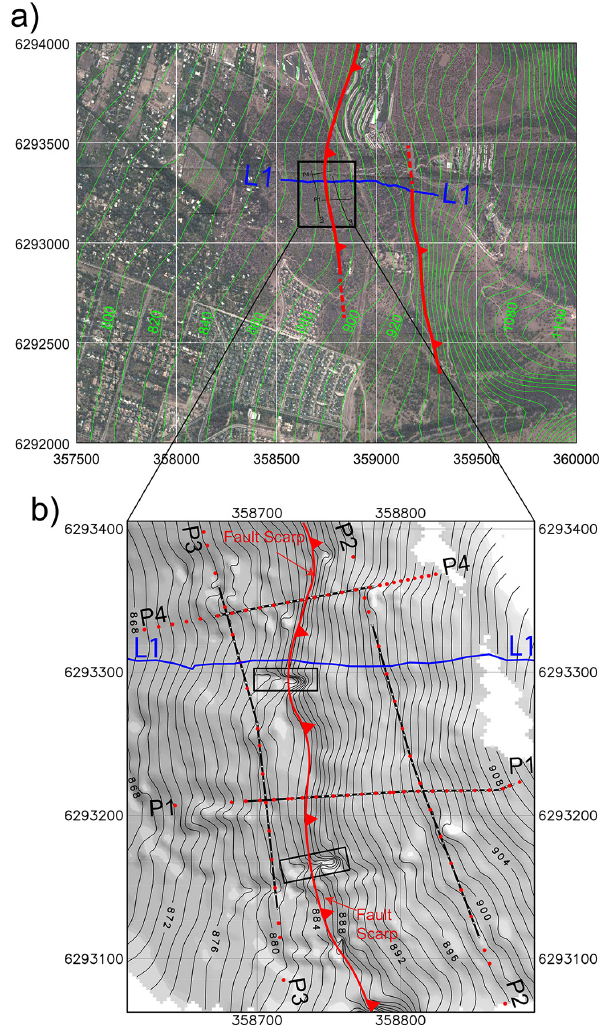
Figure 2. Location of seismic (P1–P4) and electric (L1) profiles at the Quebrada de Macul area. Green lines in (a) are contour lines of the topography based on SRTM data. Black lines in (b) are to- pographic contour lines based on D-GPS data, red dots mark shot locations and white triangles along black lines represent geophone positions. Black boxes mark the position of trenches used for ongo- ing paleoseismological studies in the area (Vargas and Rebolledo, 2012). Red line represents the approximate location of the SRF at the surface according Armijo et al. (2010). Coordinate system: UTM zone 19S,